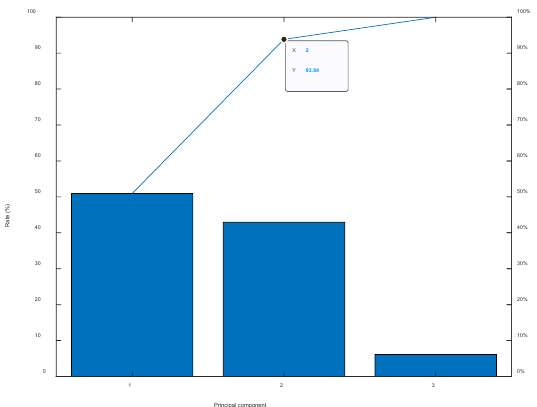
Figure 16. Dimensionality reduction of each principal component contribution rate via PCA.